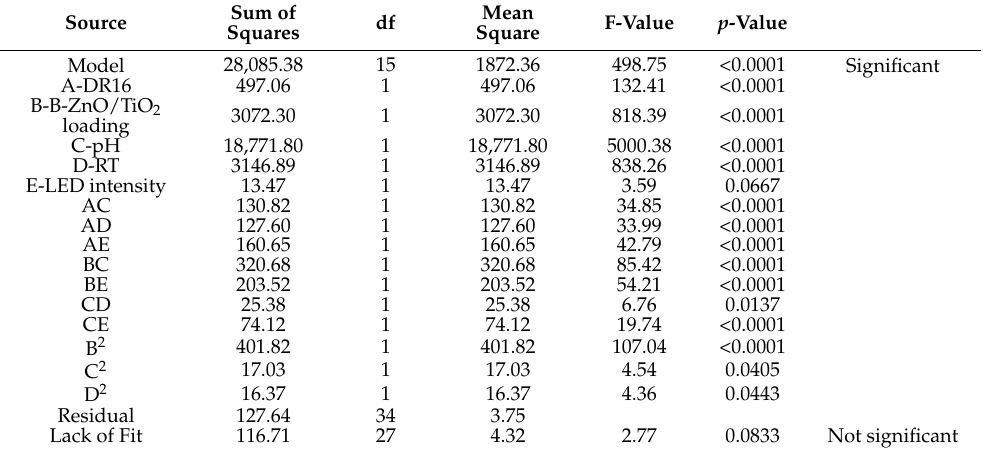
Table 4. ANOVA results of model terms.